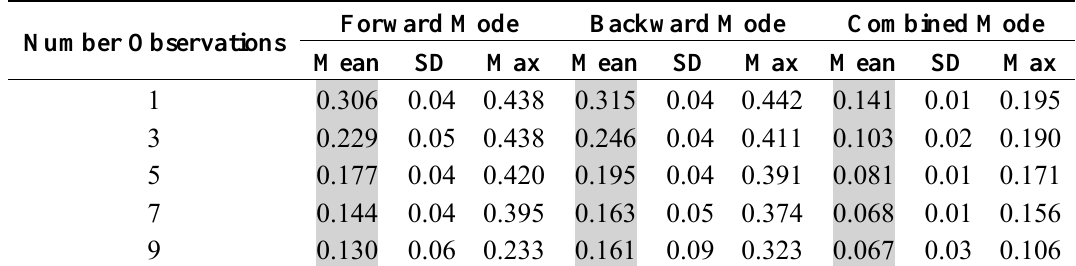
Table 4. Kansas site. Summary statistics: temporal sequence level mean normalized residuals (mean), standard deviation (SD) and maximum image-level residuals (Max) calculated from all temporal sequences generated with the same number of Landsat observations in Monte Carlo simulations. Residuals are presented for forward, backward and combined mode recursions.